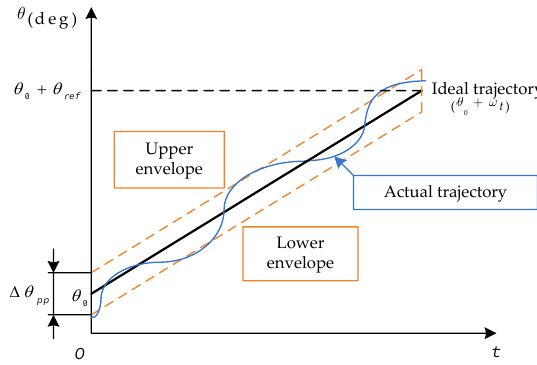
Figure 6. The method for obtaining the low-speed motion performance of OES.